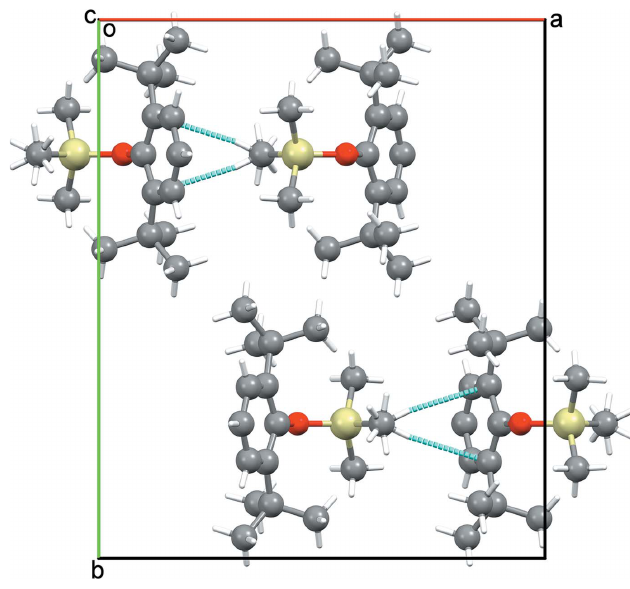
Figure 3 Unit-cell packing diagram for (II) viewed perpendicular to c with H atoms shown with arbitrary radii and intermolecular contacts less than (cid:2) rvdW as dashed blue lines.